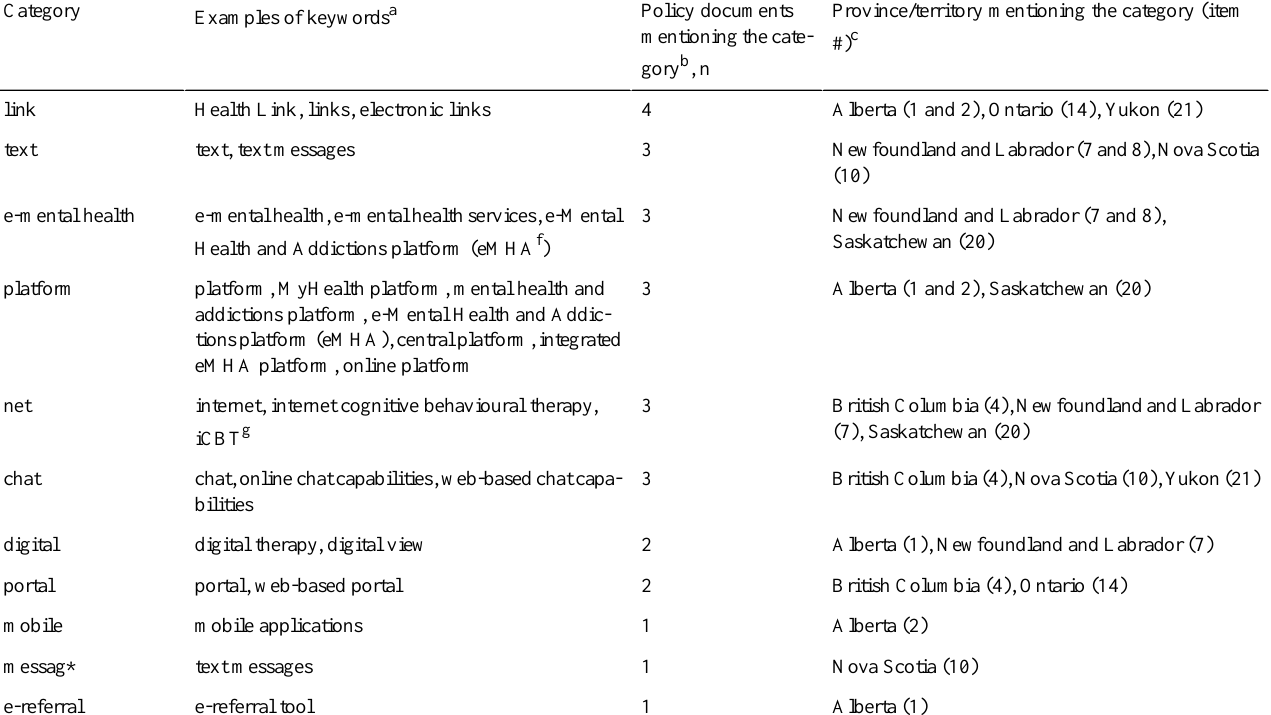
a Examples of keywords for each category were systematically extracted from the policy documents reviewed. b Compound keywords were counted twice to maintain a systematic approach to the keyword search of the policy documents. For example, telephone was counted once in tele and once in phone , and text messages was counted once in text and once in messag* . c The item number in parentheses reflects the item number in Multimedia Appendix 1.